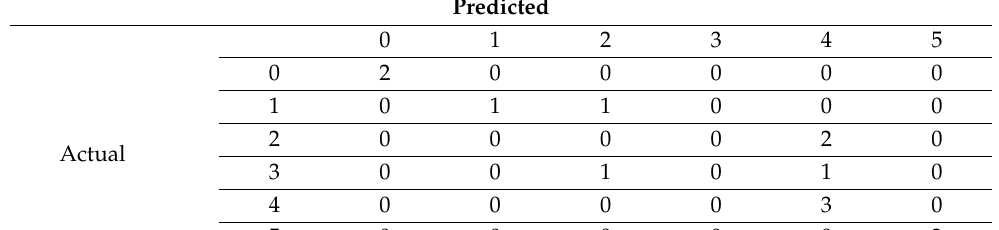
Table 12. KNN with 3 features; Accuracy 61.5%.